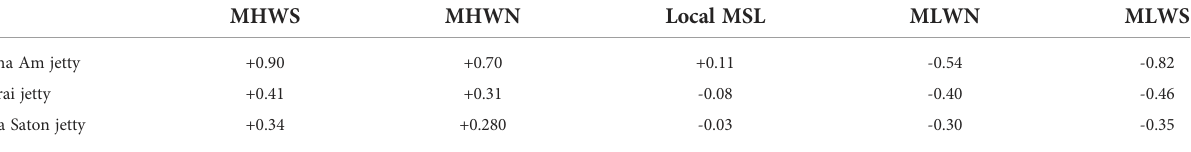
TABLE 2 Long-term tidal statistics at stations near each jetty.